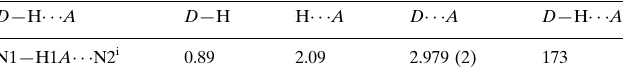
Hydrogen-bond geometry (A˚ , (cid:4)